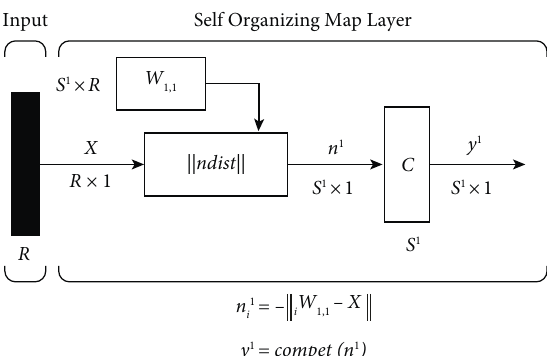
Figure 2: The low-carbon economic evaluation model based on SOM neural